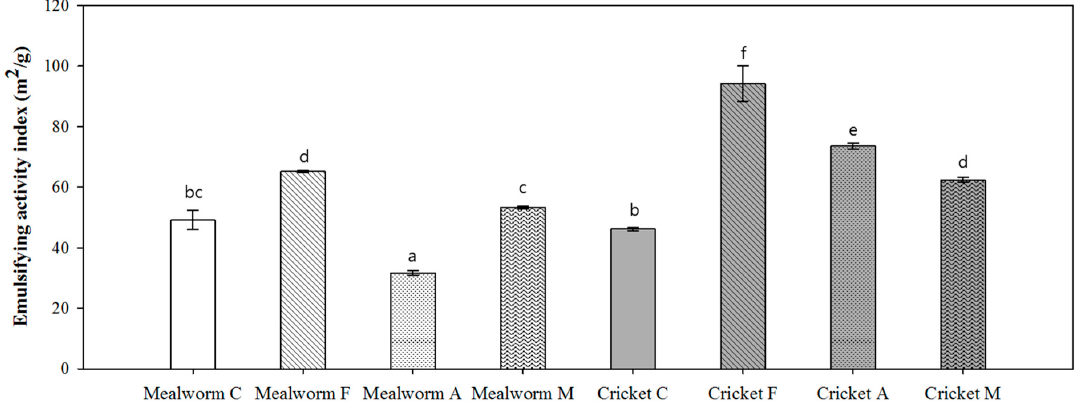
Figure 4. The emulsifying activity index (EAI) of insect proteins and their hydrolysates. The results are reported as m 2 /g. Each value is expressed as the mean ± SD ( n = 3); values marked with different letters indicate significant differences among treated groups ( p < 0.05). C, control; F, Flavourzyme; A, Alcalase; M, Flavourzyme + Alcalase.